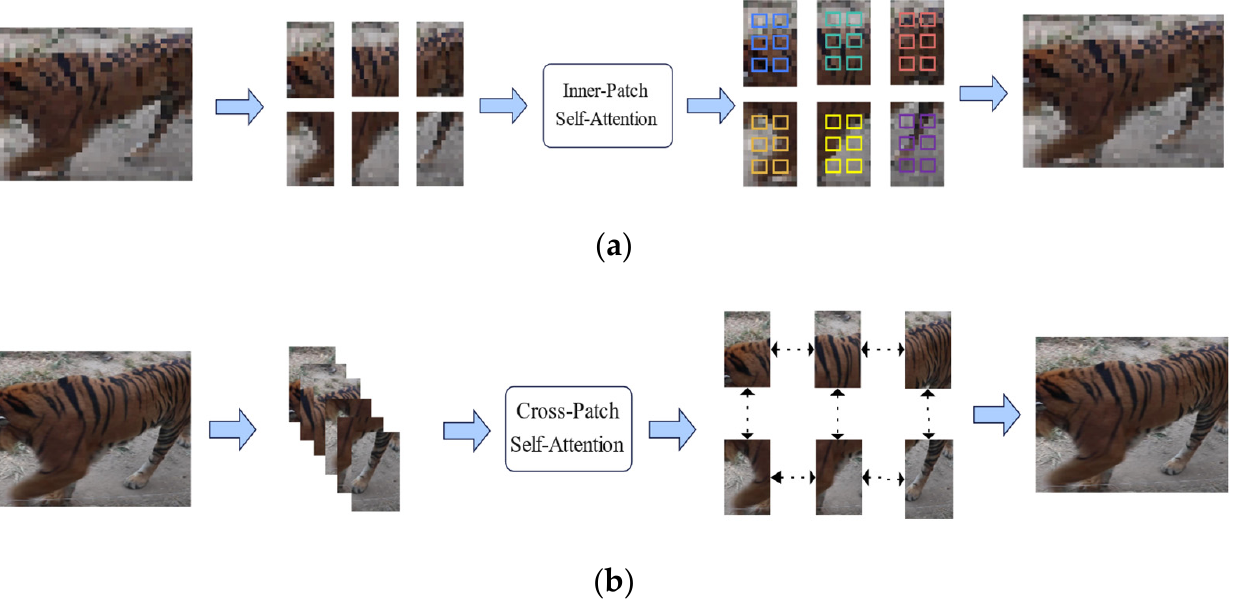
Figure 4. Principles of the IPSA module and CPSA module: ( a ) IPSA module; and ( b ) CPSA module.